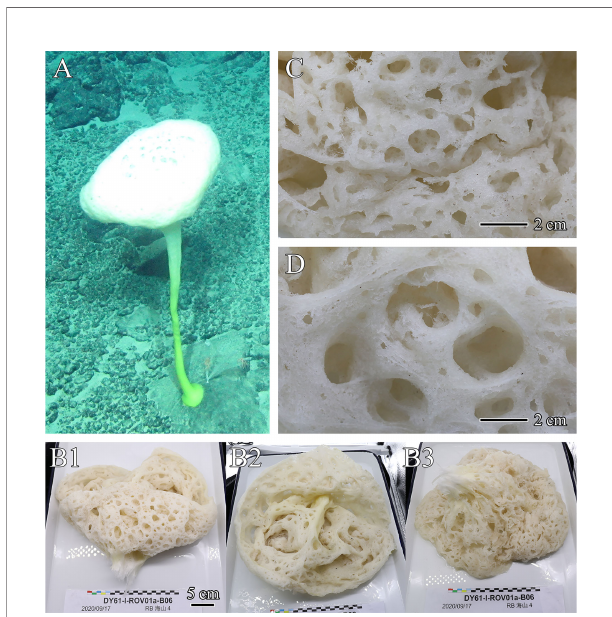
FIGURE 1 | Flavovirens hemiglobus gen. et sp. nov., specimen of holotype. (A) In situ image. (B) Whole collected specimen, lateral view of body head (B1) , top view of opening (B2) , and bottom view of body head (B3) . (C) Close-up view of dermal surface. (D) Close-up view of atrial